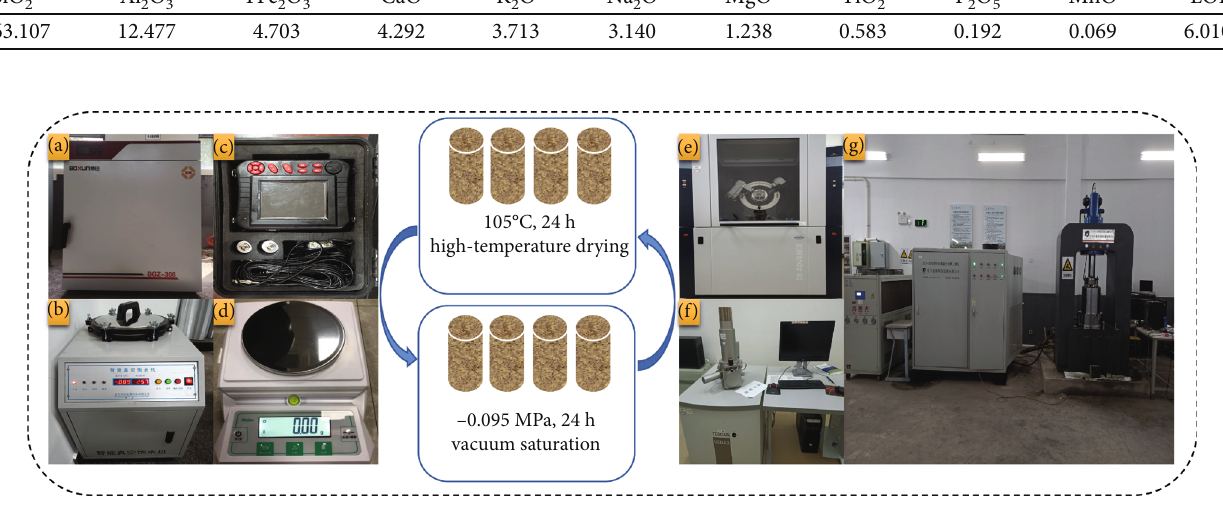
Figure 4: Test procedure and test apparatus: (a) drying oven; (b) water saturator; (c) nonmetallic ultrasonic detection analyzer; (d) electronic scale; (e) X-ray di ff ractometer (XRD); (f) scanning electron microscope (SEM); (g) triaxial